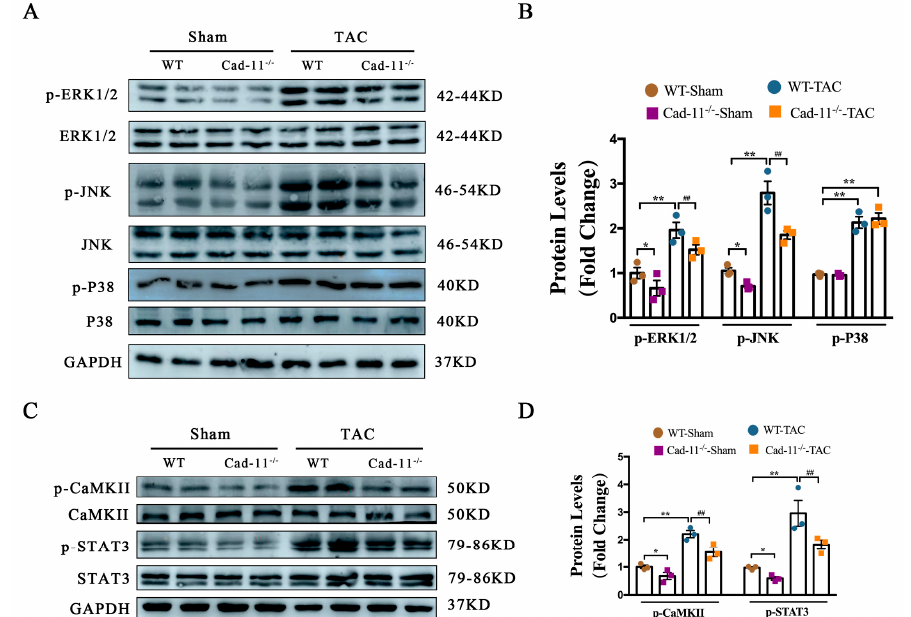
Figure 8. Loss of Cad-11 alleviates pressure overload-induced LV remodeling partially through MAPK and CaMKII–STAT3 pathways. ( A , B ) Representative western blotting and quantitative data of phosphorylation protein levels of ERK, JNK, and P38 ( n = 3 in each group). ( C , D ) CaMKII, STAT3 in wild-type (WT) and Cad-11 − / − mice LV tissues following a 4-week sham or TAC operation ( n = 3 in each group). Quantification of each protein expression level was normalized to GAPDH levels. Data were presented as mean ± SEM, * p < 0.05, ** p < 0.01 vs. WT-Sham group. ## p < 0.01 vs. WT-TAC group.